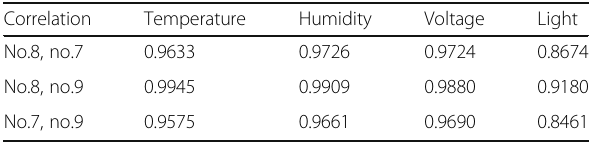
Table 2 Correlation coefficient of